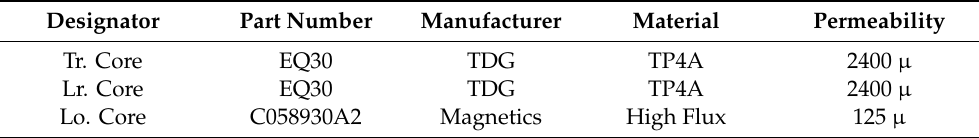
Table 8. Magnetic core selection in reference design.